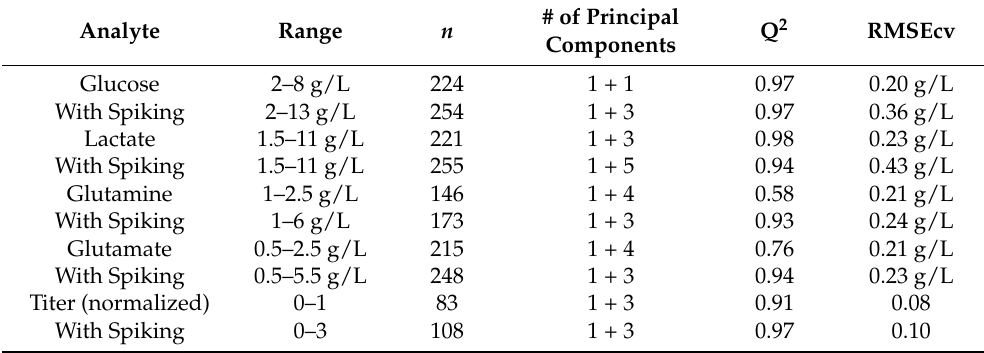
Table 1. Summary of key parameters for Raman OPLS models from spiked and unspiked samples from 250 mL mini bioreactors. Range indicates the concentration range of the analyte within the model; n states the number of datapoints used in the model; # of principal components states, in addition to one predictive component, how many orthogonal components the model utilizes; Q 2 denotes the goodness of prediction; RMSEcv equals to the root mean square error of